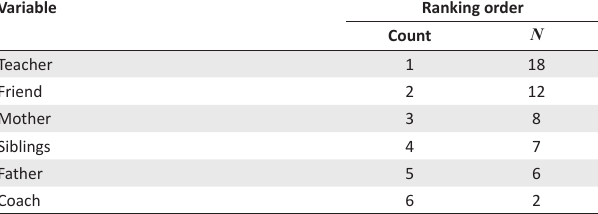
TABLE 10: Influential people in mathematics (multiple response and rank order). Variable Ranking